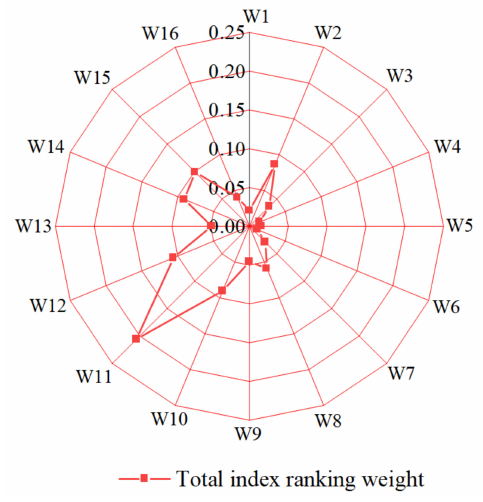
Figure 5. Total index ranking